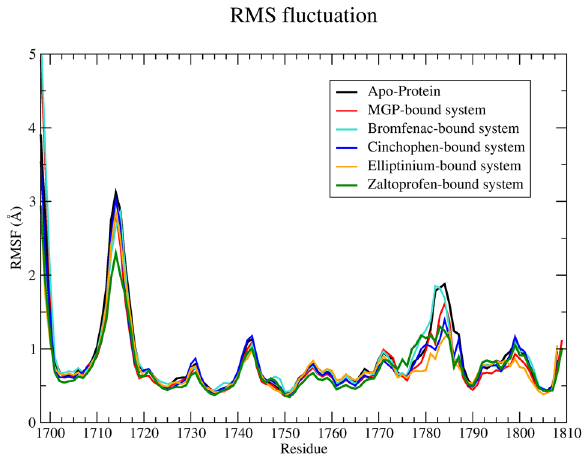
Figure 3. Root mean square fluctuation (RMSF) profiles of each system.